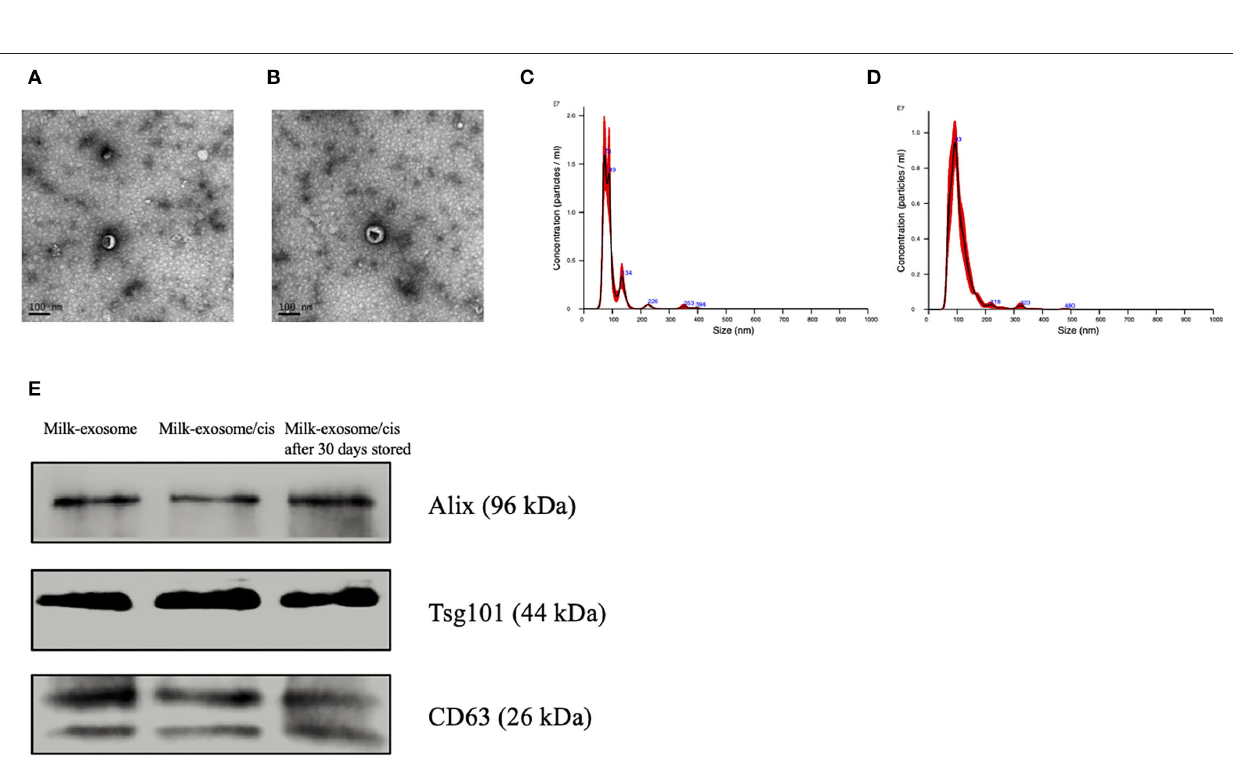
Frontiers in Medicine |